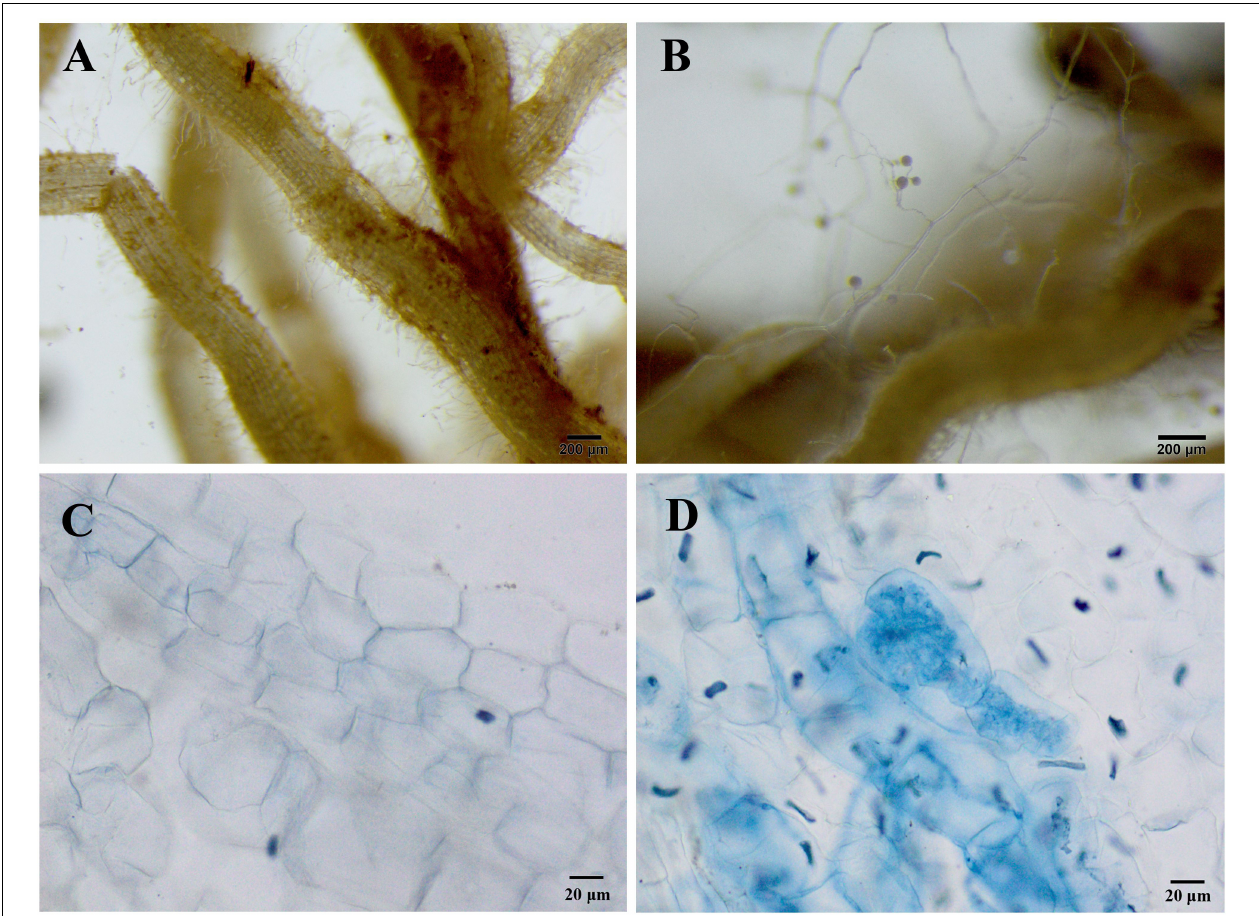
FIGURE 1 | Microphotographs showing the symbiotic relationships between Funneliformis mosseae and Robinia pseudoacacia seedlings grown under the control Pb treatment (0 mg Pb kg - 1 soil) for 4 months. (A) Roots of non-inoculated plants without any extraradical hyphae and spores. (B) Roots of inoculated plants with extraradical hyphae and spores. (C) Root cells of non-inoculated plants. (D) Intraradical hyphae and arbuscular in the root cells of inoculated plants. (A,B) 25 × magnification; (C,D) 200 ×